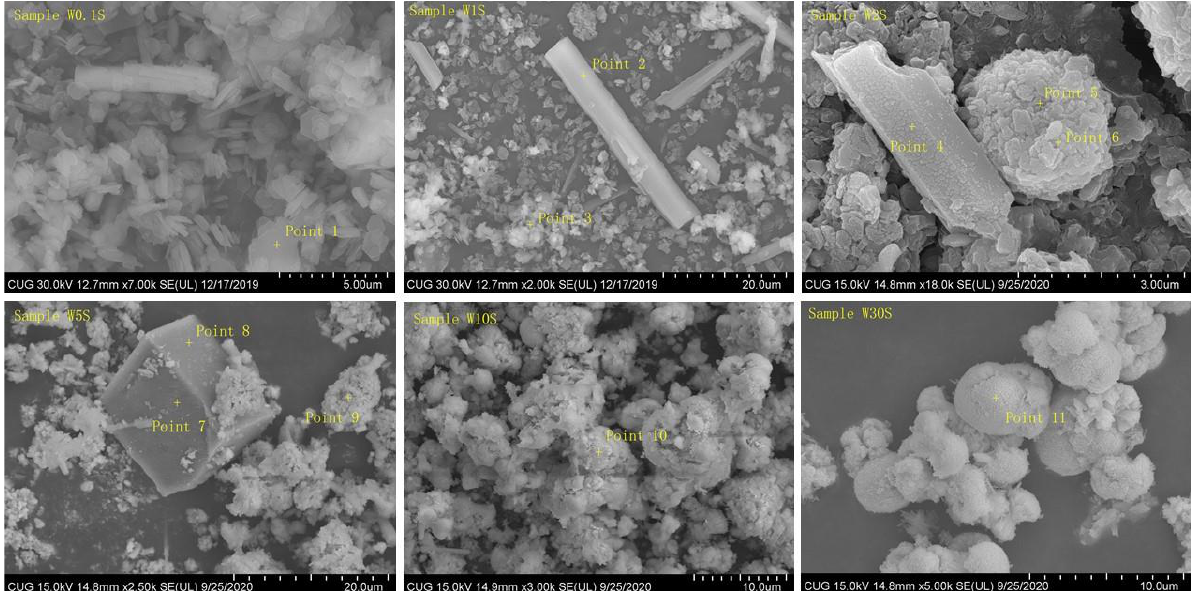
Figure 4. SEM images of hydrocalumite samples after reaction with tungstate solution. Point 1–11 are the locations of the dots on the sample during EDX analysis.